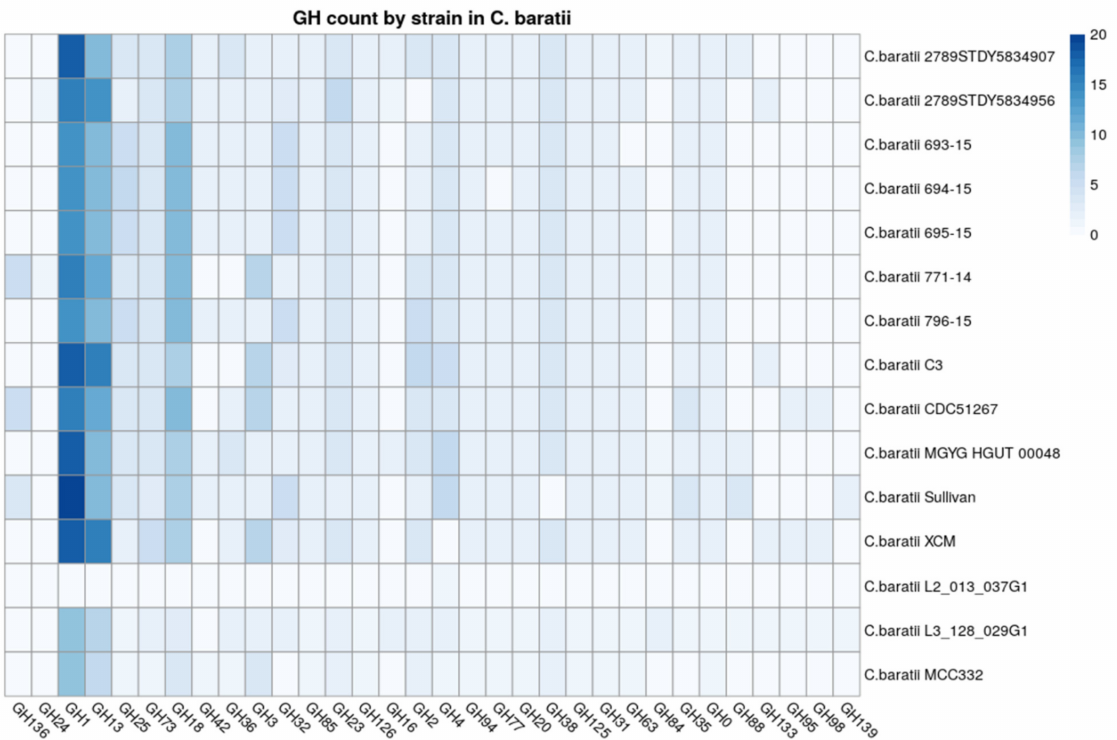
Figure 3. Percent of total clusters of orthologous groups (COGs) in pangenome. Percentage of total Cluster of Orthologous group annotated in the Clostridium baratii core genome and accessory genes.